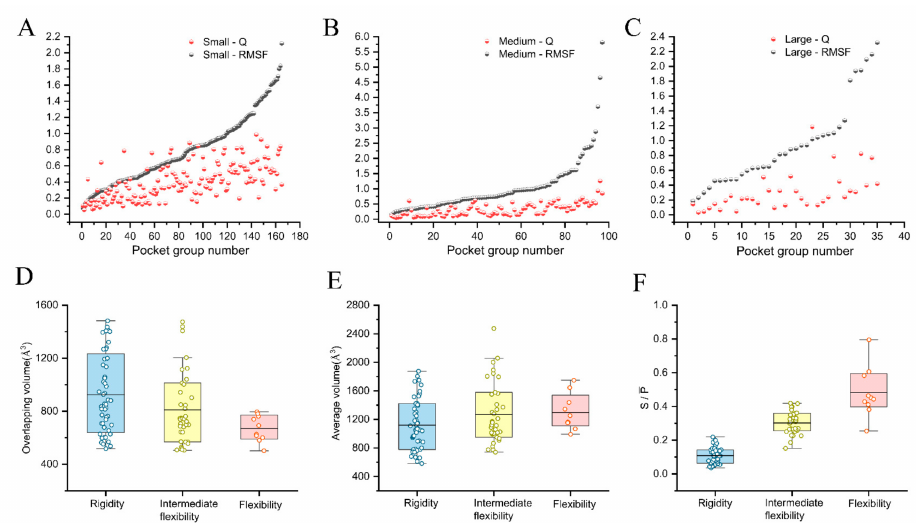
Figure 3. The correlation between the flexibility scores (Qs) and RMSFs of pocket groups in Testing Sets I–III: small ( A ), medium ( B ), and large ( C ). The topological information distribution of overlap- ping volume ( D ) and average volume ( E ) of pocket groups in the medium. The distribution of S/P of pocket groups in the medium ( F ). The mean values are colored